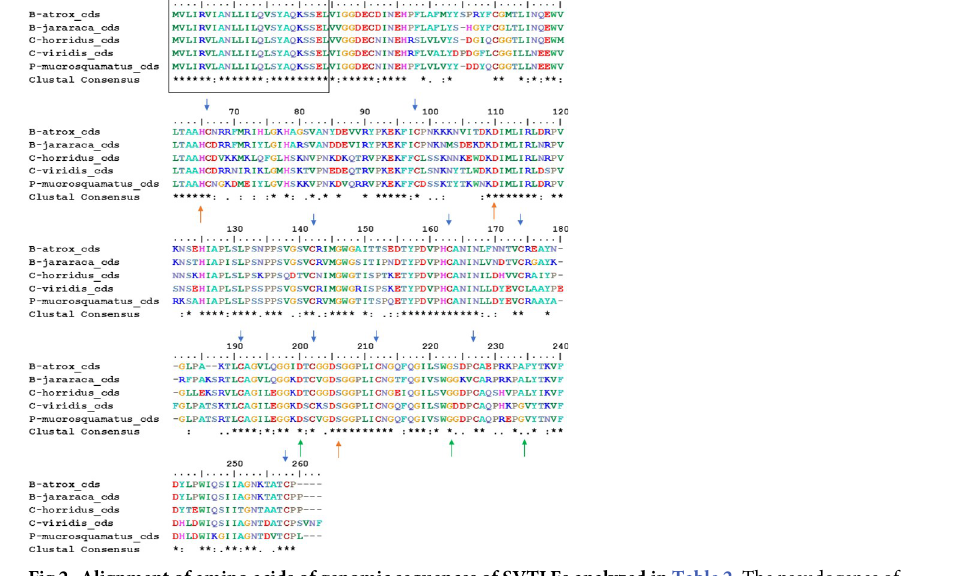
Fig 2. Alignment of amino acids of genomic sequences of SVTLEs analyzed in Table 2. The pseudogenes of Bothrops jararaca and Protobothrops flavoridis were not analyzed. The black box indicates the signal peptide, blue arrows show the cysteines, orange arrows show the catalytic amino acid triad, and green arrows show the binding